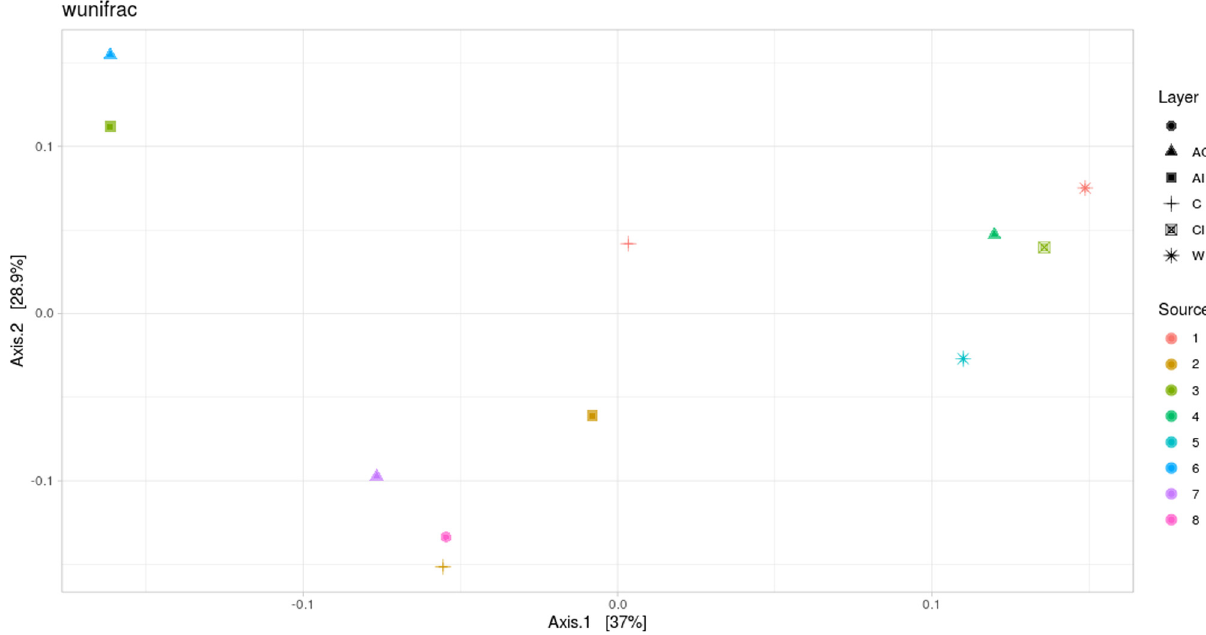
Figure 4: Beta biodiversity: PcoA weighted